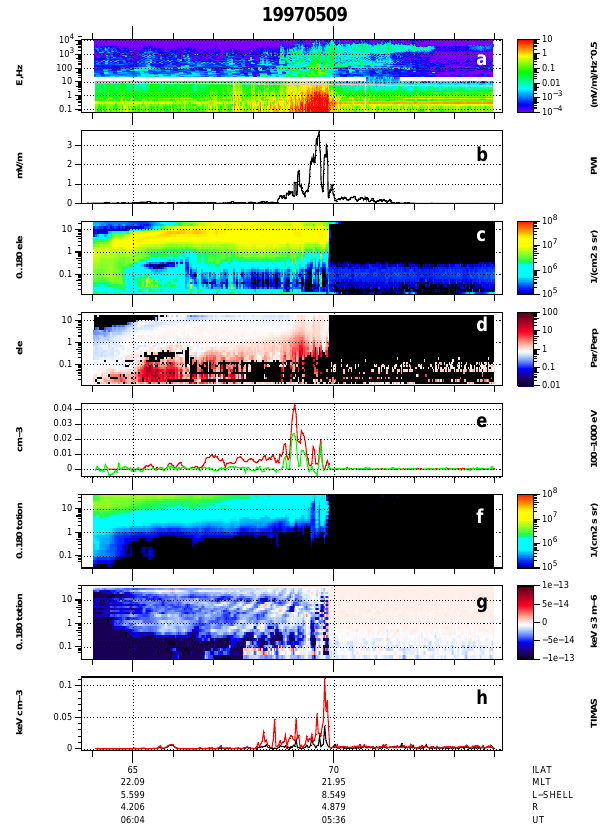
Fig. 3. Polar data for event 9 May 1997: ( a ) EFI ( < 20Hz) and PWI ( > 26 Hz) omnidirectional electric wave field amplitude spec- trograms between 0.1Hz and 10kHz, ( b ) PWI electric wave ampli- tude in frequency range 26–500Hz, ( c ) HYDRA pitch-angle aver- aged electron differential energy flux spectrogram, ( d ) ratio of par- allel to perpendicular distribution function (Janhunen et al., 2004a), ( e ) parallel versus perpendicular middle-energy anisotropy (0.1–1 keV) in red and up minus down anisotropy in green, ( f ) TIMAS pitch-angle averaged total ion differential energy flux spectrogram, ( g ) quantity S (Eq. 1) computed from panel f, ( h ) “free” energy density of ion shell distributions in black, ’original’ minus “free” in red. The CPS/BPS boundary in this event is probably near ILAT 64. Panels b, e and h are